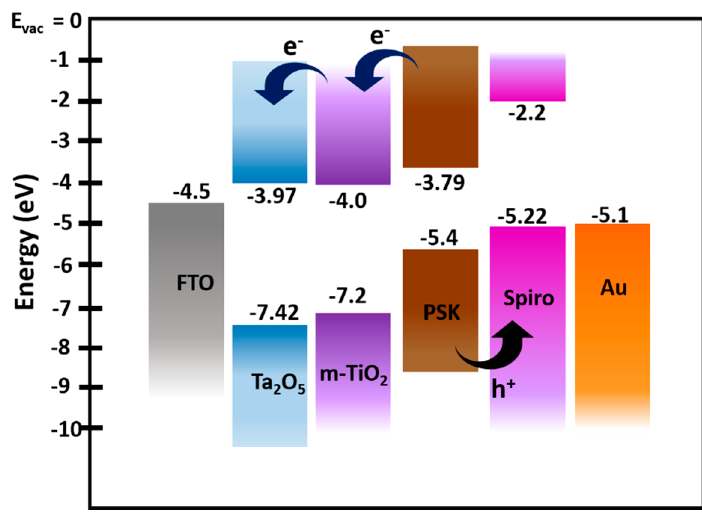
Figure 4. Energy level diagram of FTO/amorphous Ta 2 O 5 /meso-TiO 2 /perovskite/spiro-OMeTAD layered stacks. The energy level for Ta 2 O 5 was determined by UPS and UV–Vis spectroscopy, and for other device stack layers, the values were adopted from the